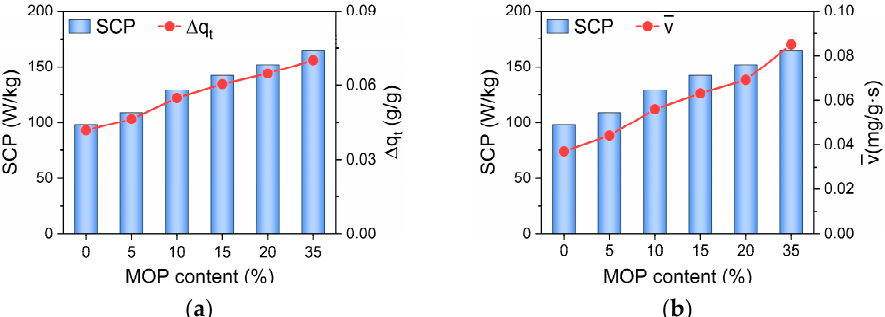
Figure 6. Relationship between ( a ) cyclic working capacity ( Δ q t ), ( b ) water adsorption rate ( v ), and SCP of MOP/MIL-101(Cr)-water working pairs at different MOP 3 content. The COP C is defined as the ratio of the useful energy provided by the device and the required input [43] ⋅ cycle C